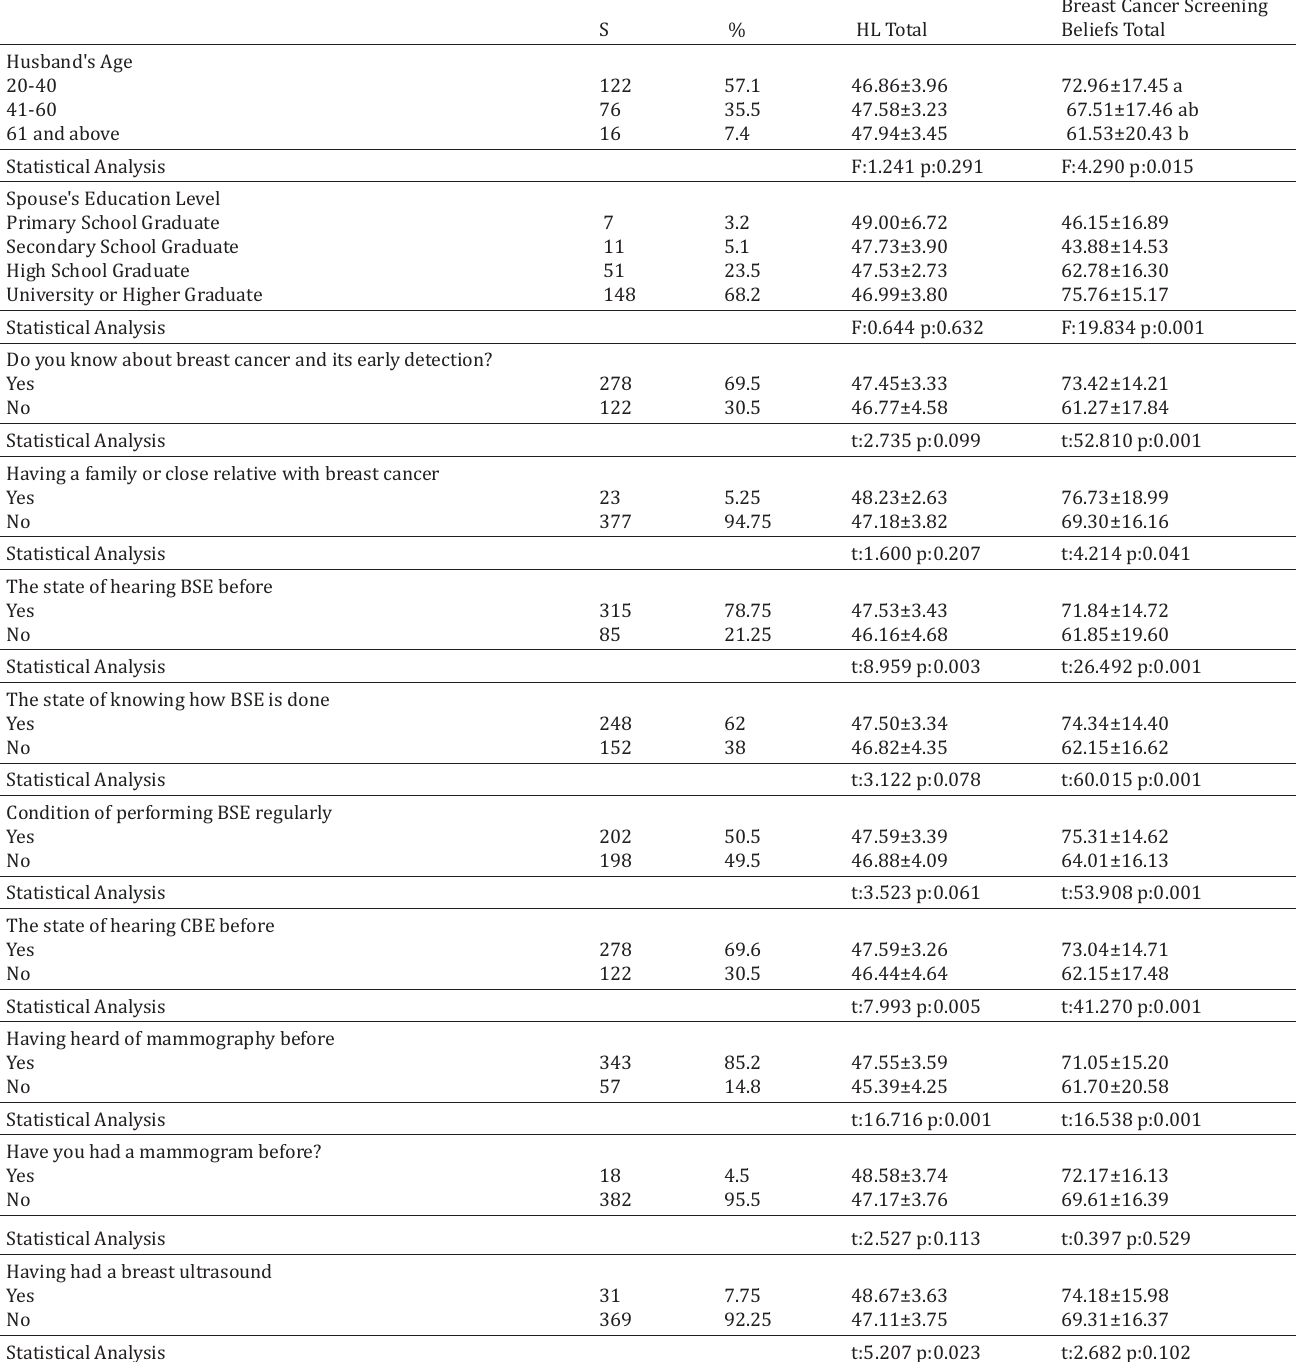
Woman's Spouse and Pregnancy Status, Information Distribution on Breast Cancer and Early Diagnosis in Breast Cancer